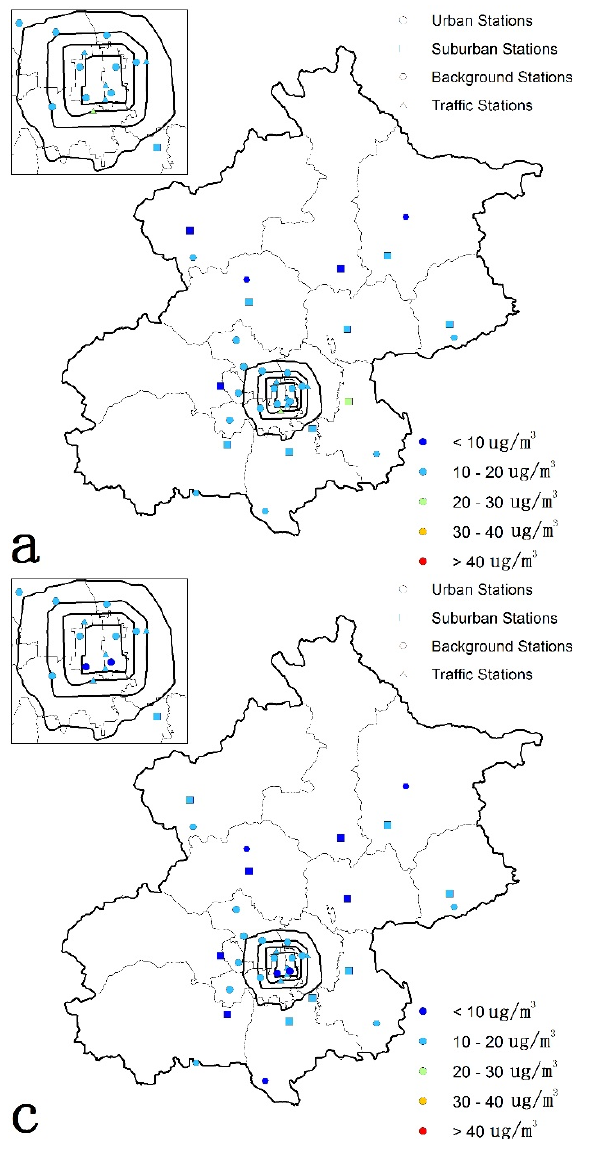
Figure 9. Seasonal variations of SO 2 concentrations for the 35 air quality monitoring stations (( a ) spring; ( b ) summer; ( c ) autumn; ( d )